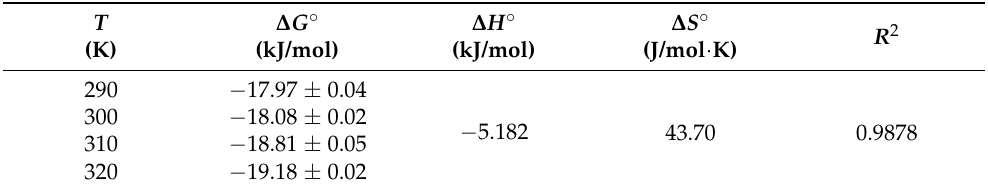
Table 3. Thermodynamic parameters of Cu(II) adsorption onto poly(acrylic acid/chestnut shell pigment) at contact time = 24 h, pH = 6, adsorbent dosage = 1 g/L.